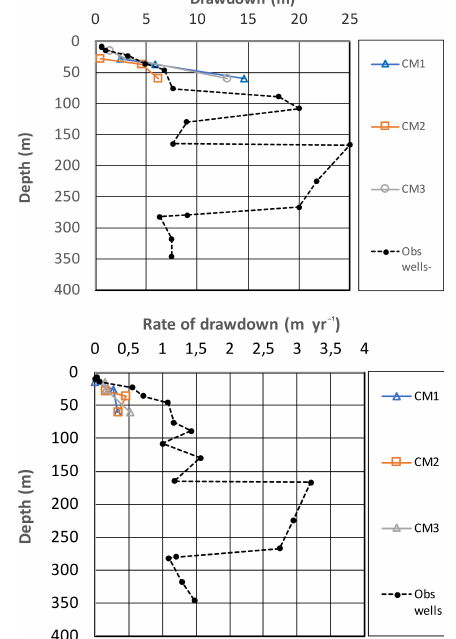
Figure 5. Measured drawdown (a) and rate of drawdown (b) in observation wells, and new piezometers installed at CM1–CM3.